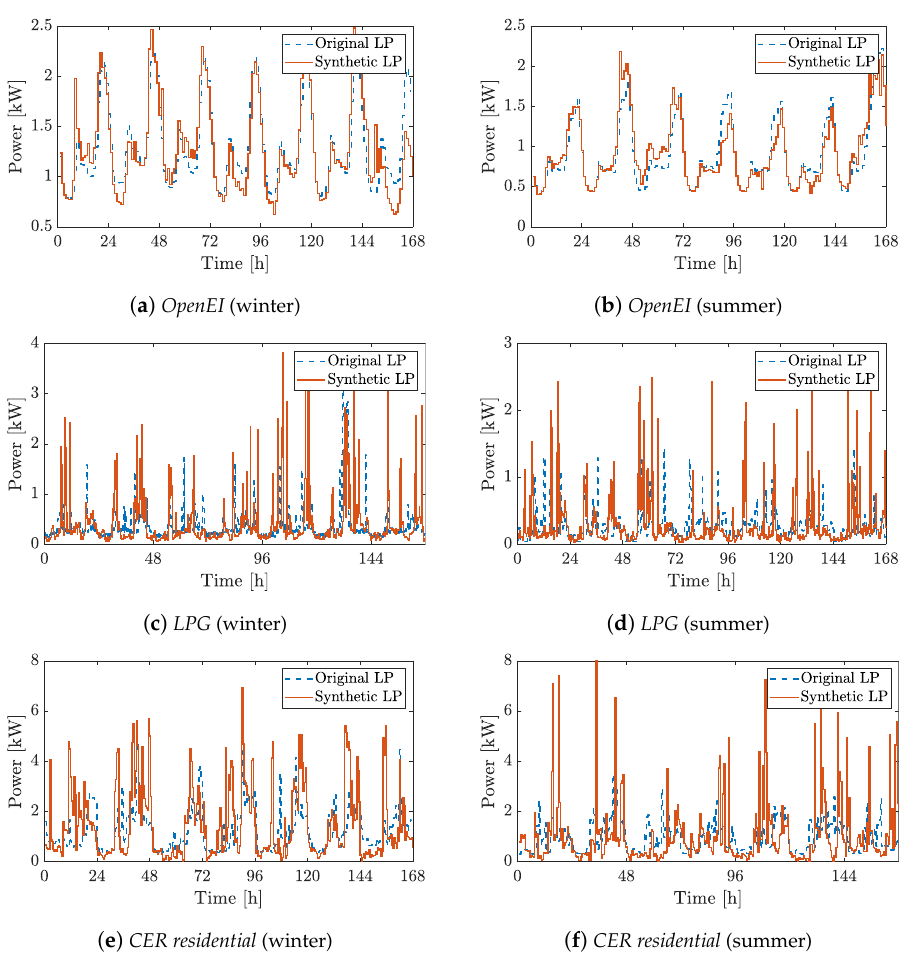
Figure 9. Qualitative comparison of one-week-long SLPs and LPs in winter (plots on the left) and in summer (plots on the right). Both the SLPs and the original LPs are randomly extracted from the most populated cluster of each data